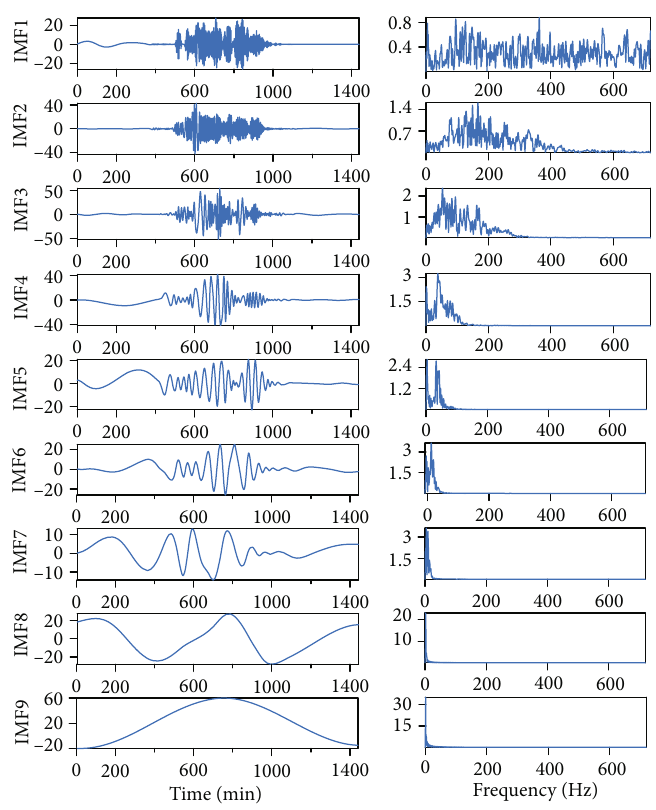
Figure 6: EMD decomposition results.